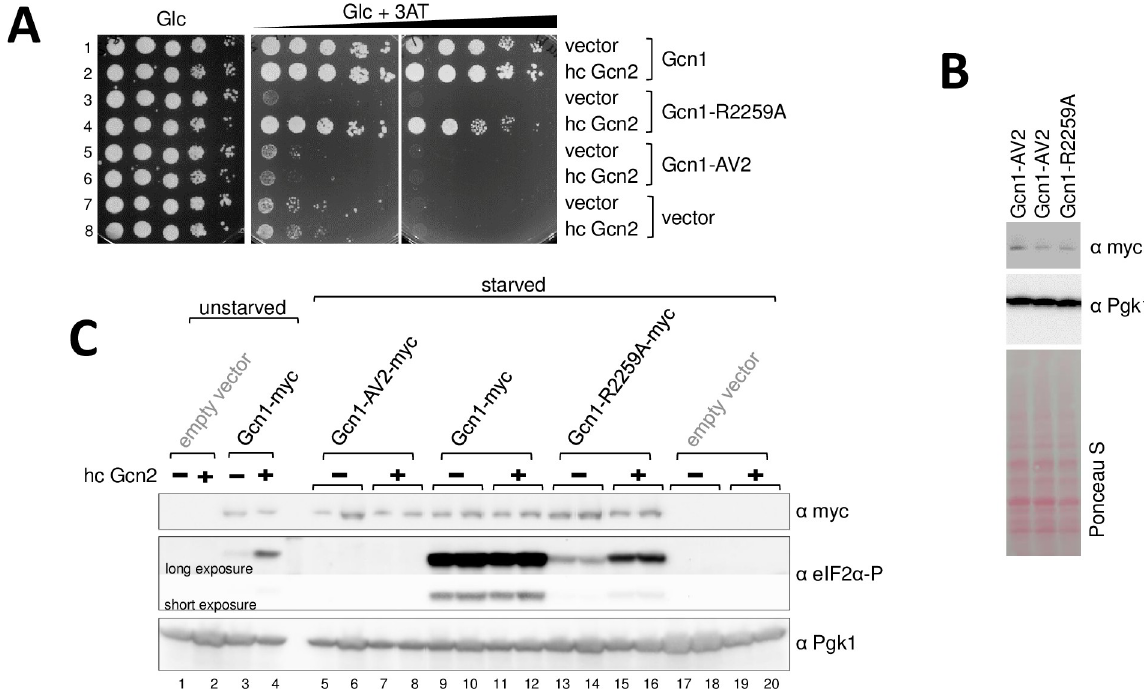
either myc-tagged Gcn1-AV2 or Gcn1-R2259A, was grown in liquid medium to exponential phase, harvested, and the cell extract subjected to western blotting as done in Fig 2B, just that antibodies against the myc tag and against Pgk1 were used. The PonceauS stained membrane is shown as an additional control for equal loading. Images are representative results for two independent experiments. (C) The AV2 mutations impair eIF2 α -P levels more so than the R2259A substitution. The cells from (A) were subjected to starvation via the addition of 3AT, and